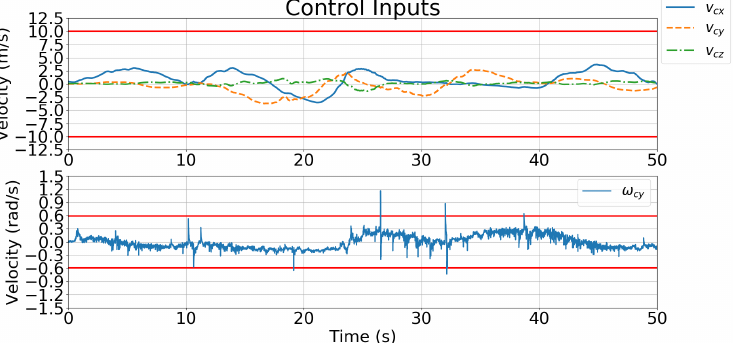
Figure 23. Case 1: velocity control input of the IBVS